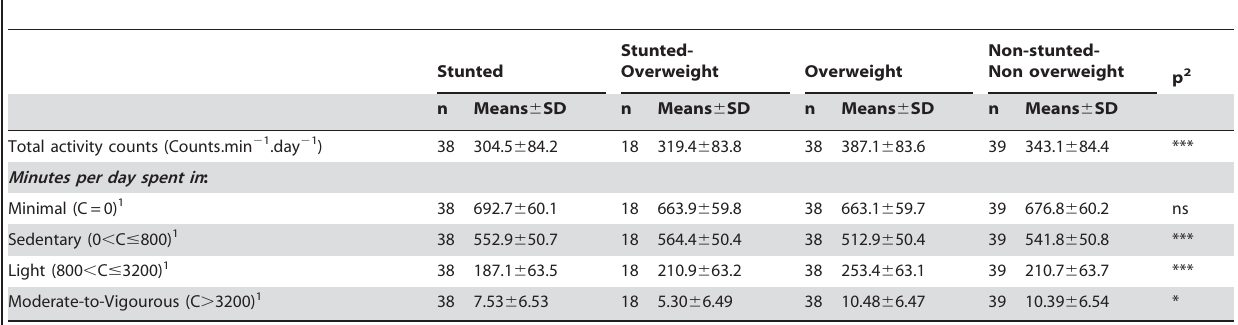
Table 3. Physical activity for the four groups of children (gender, age and ‘‘being at school’’ adjusted).